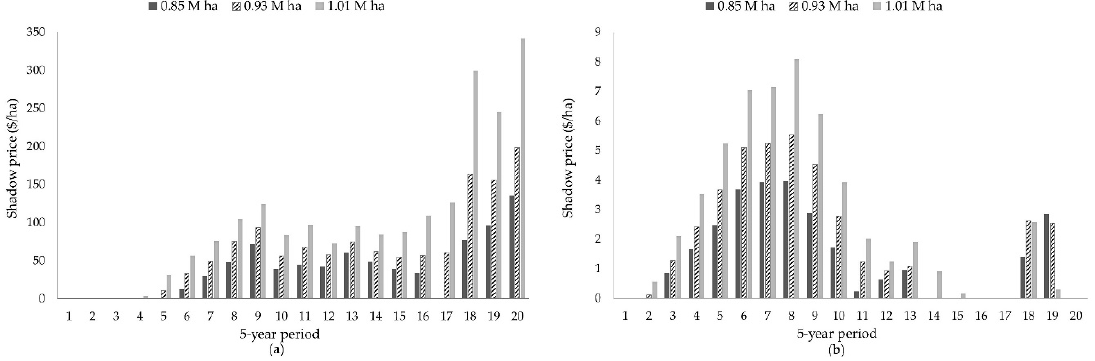
Figure 8. Marginal value estimates for old forest under three fixed old forest target levels ( a ) and marginal values associated with the aspen species volume constraints with these old forest target levels ( b ).